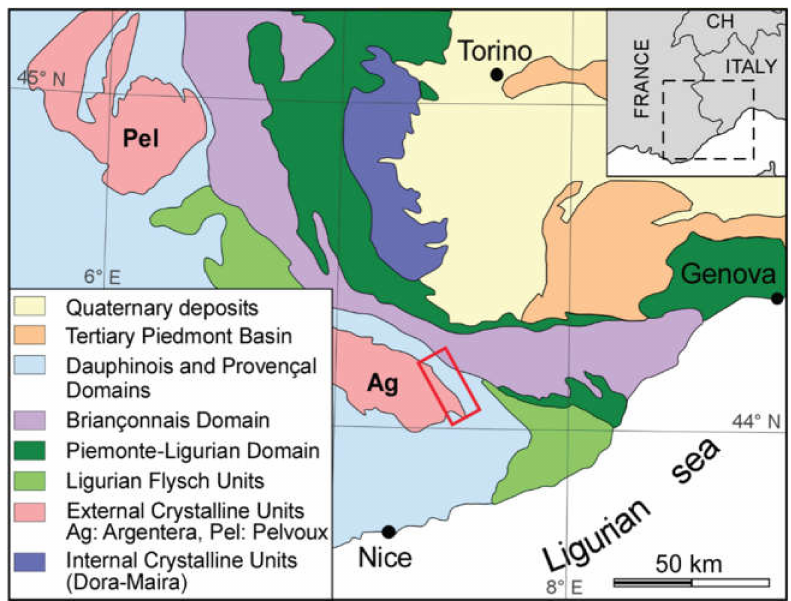
Figure 1. General geological map of the south-west Alps. The red rectangle shows a part of the study area (Provençal Domain) (after